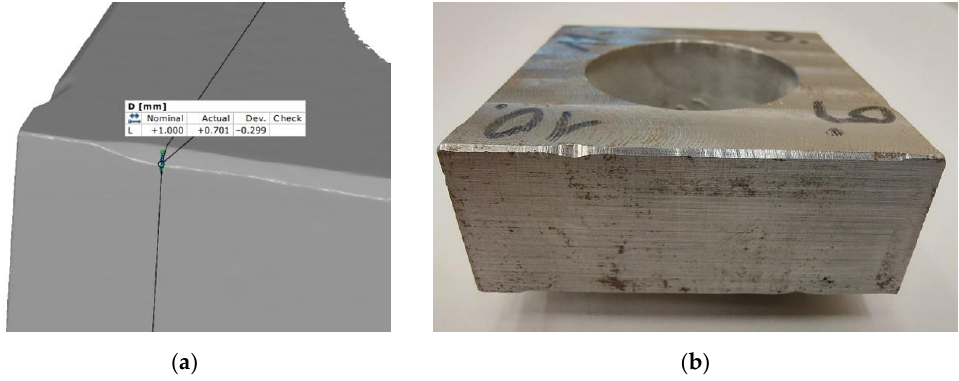
Figure 8. An example of a disturbed chamfer width: ( a ) scan; ( b ) view of the sample.